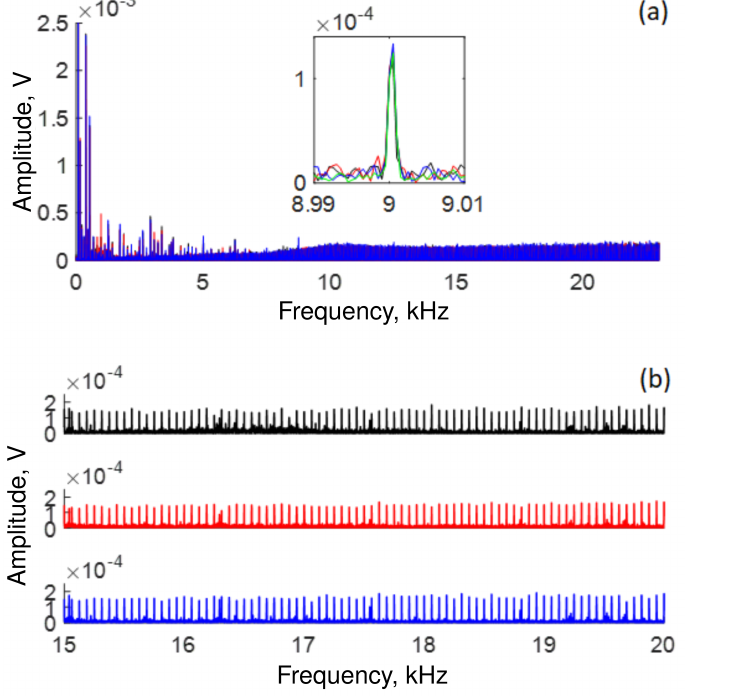
Figure 13. Response of a 10 m loop OFSI: ( a ) All frequencies detected during ∼ 2.5 s for several average output power values adjusted by the QWR (See Figure 1), inset shows a close-up on 9 kHz. ( b ) close- up on region from 15 kHz to 20 kHz. Black trace = 10 µ W, red trace = 30 µ W, blue trace = 60 µ